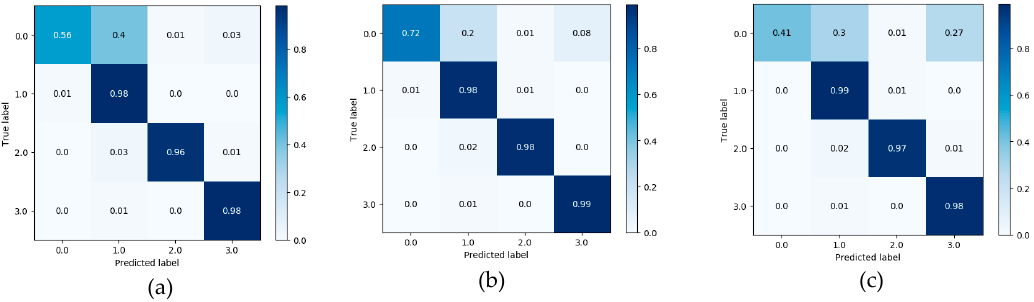
Figure 9. Confusion matrix obtained from FMS-Net classifier at three di ff erent paces: 0.78 m / s ( a ), 1.0 m / s ( b ) and 1.25 m / s class ( c ). Table 2. Summary of classification performance of di ff erent models at unsynchronized speed.